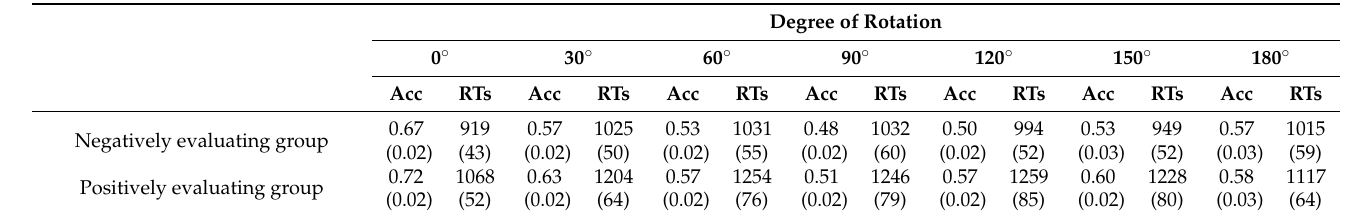
Table 2. The accuracy rates and response times for the two experimental groups in the mental rotation task. The values in parentheses denote the standard